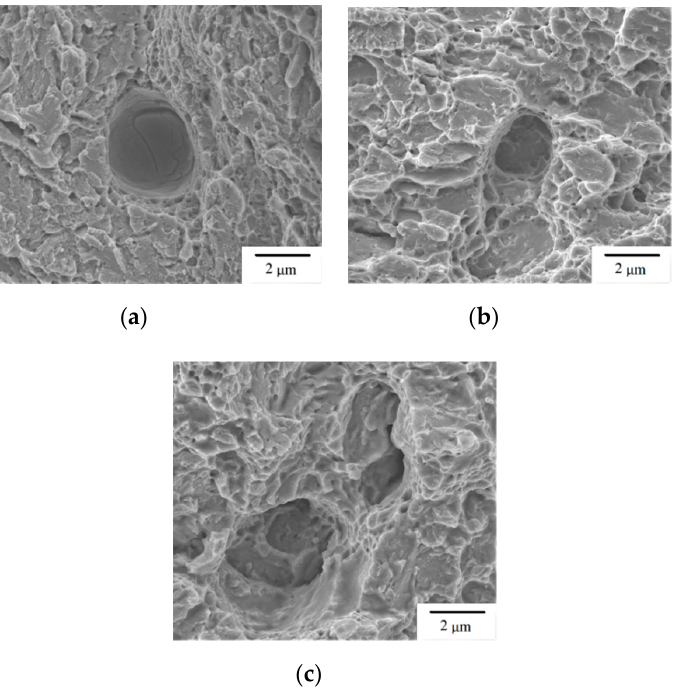
Figure 9. SEM micrographs of micro-pores and cleavage facets observed on the fracture surface: ( a ) Group A; ( b ) Group B; ( c ) Group C.